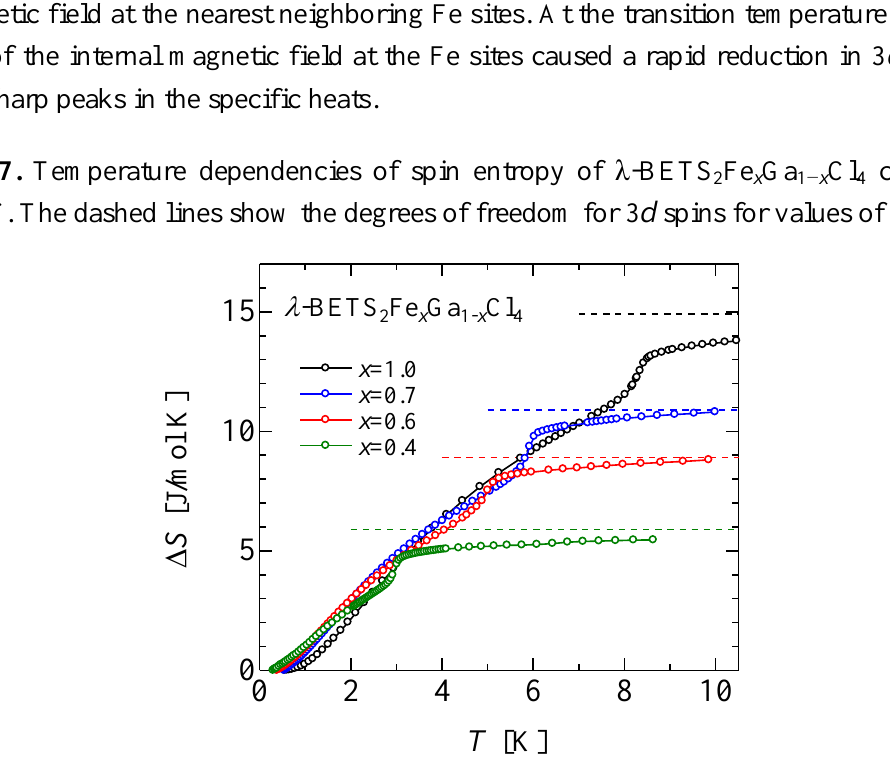
Fe Ga Cl calculated 2 x 1− x 4